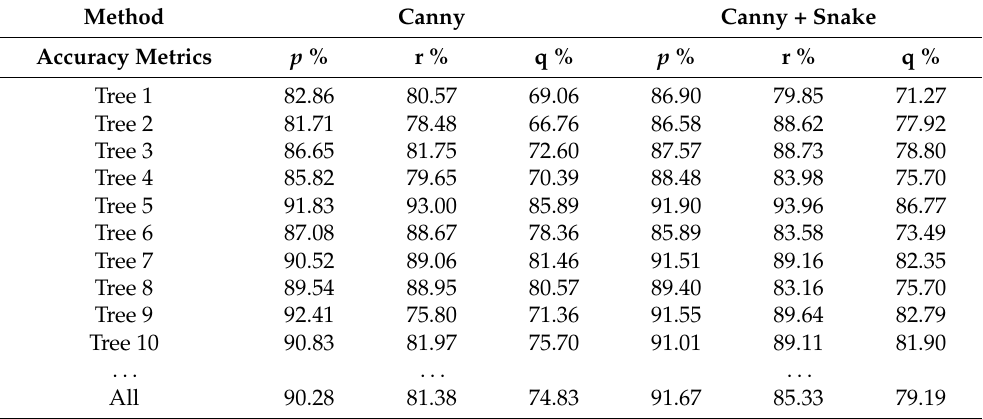
Table 2. Segmentation precisions of 10 trees randomly selected from the experimental plot. Method Canny Canny + Snake Accuracy